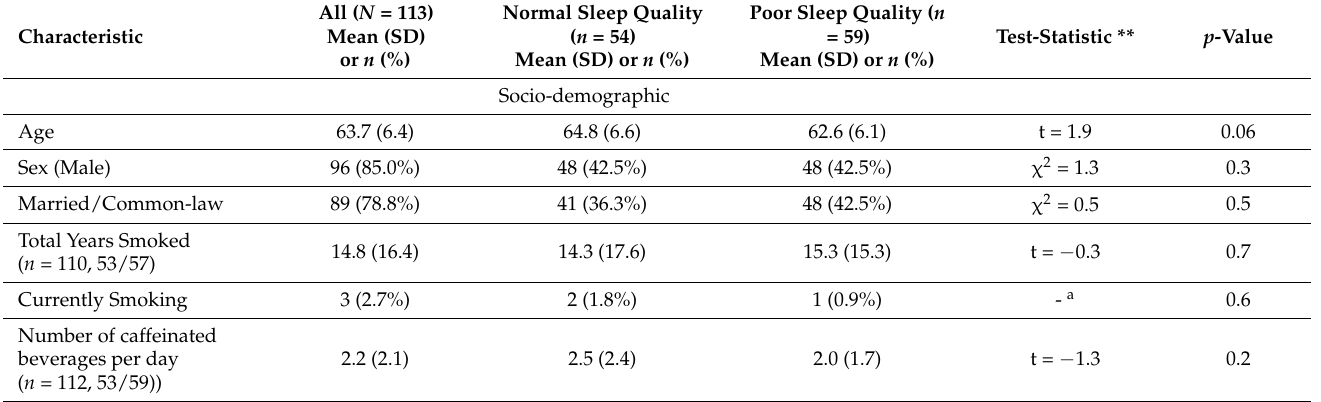
Table 1. Participant characteristics in total population and those with normal sleep compared with poor sleep